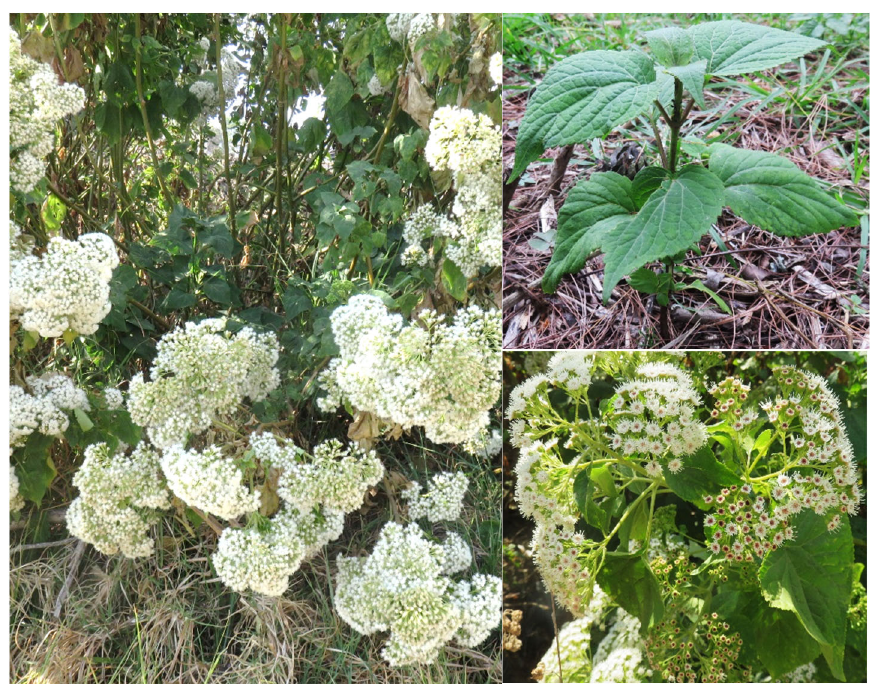
Figure 1. Typical wild plants of A. pichinchensis growing in the municipality of Tepoztlán in the state of Morelos, Mexico.